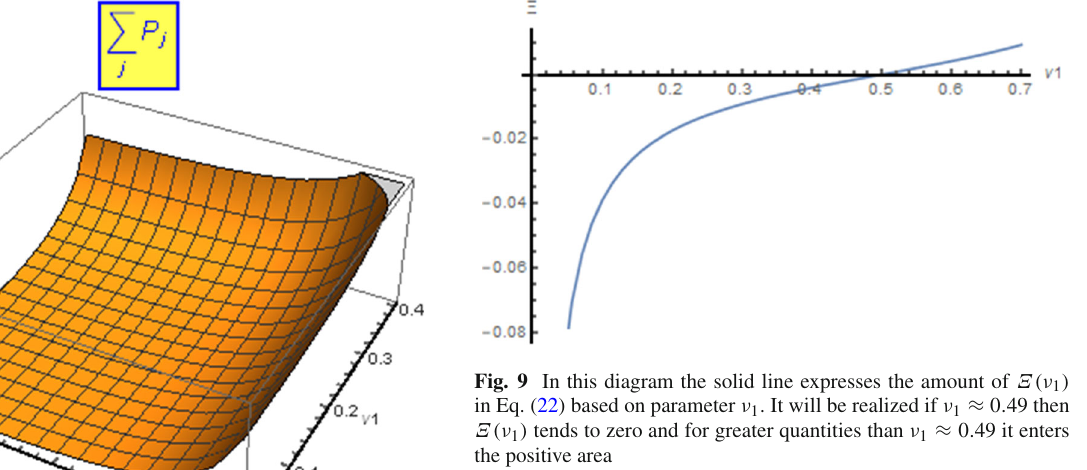
≈ 0 . 49 it enters 1